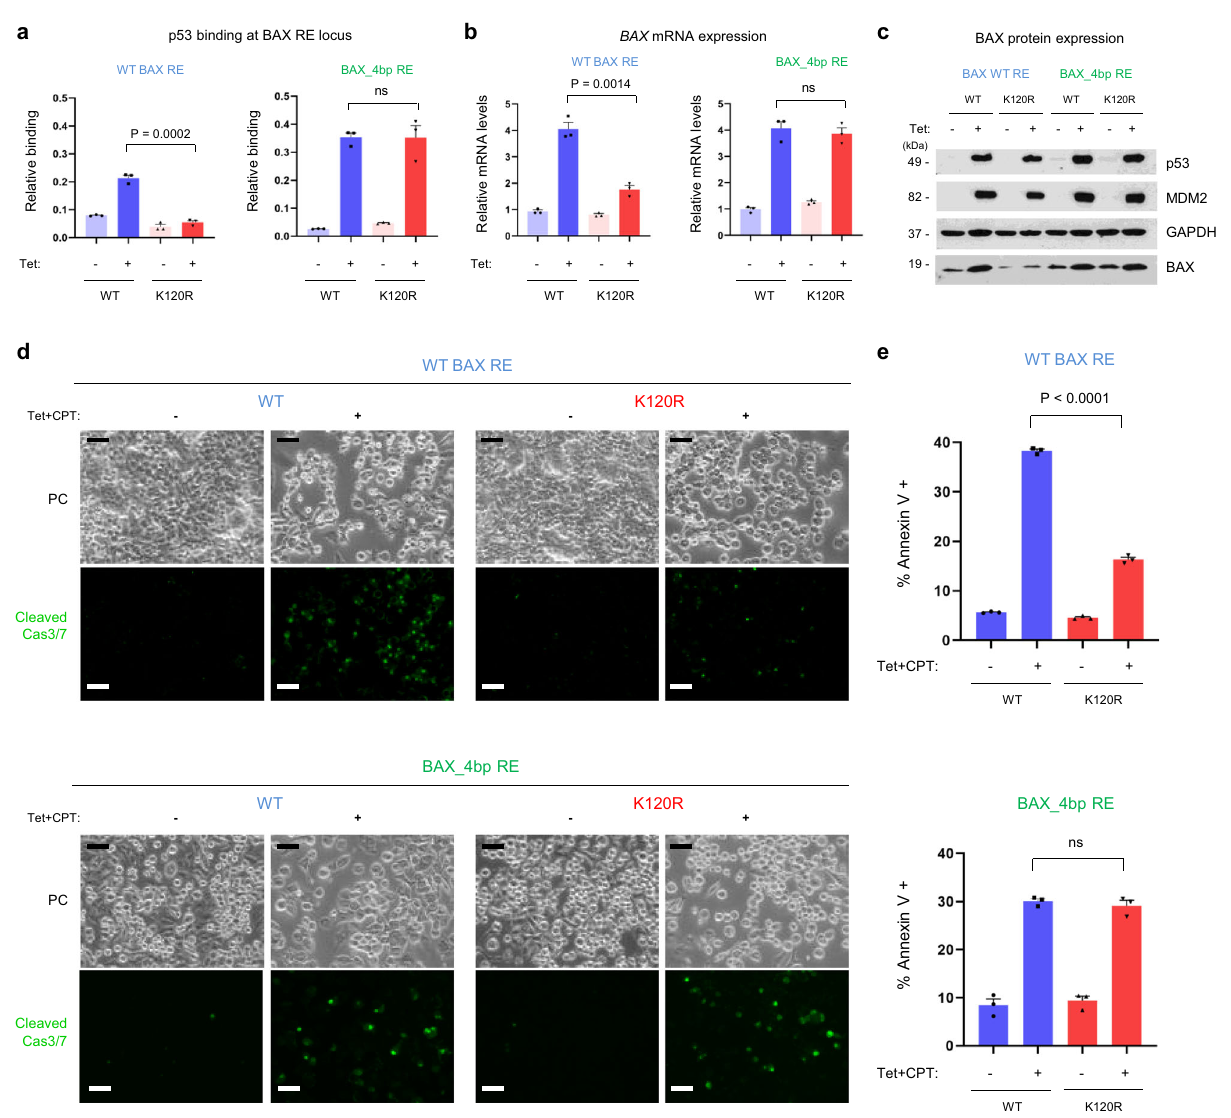
Fig. 5 Genomic editing of BAX RE modi fi es p53 binding and interconverts cell fate outcome. a ChIP signals at the genomic BAX RE locus for WT (blue) and K120R (red) p53 in cells with a WT BAX RE (left) or genetically edited BAX_4bp RE (right). Graphs represent precipitated DNA relative to an input (total) DNA and show cumulative data from three independent experiments (mean ± s.e.m.). b Quantitative polymerase chain reaction (qPCR) of BAX mRNA (represented relative to GAPDH mRNA) from the same cells as in panel a . The graphs show cumulative data from three independent experiments (mean ± s.e.m.). c Representative Western blot from three independent experiments. Blots were probed with antibodies speci fi c for p53, MDM2, GAPDH, and BAX proteins. d Same cells as in panels a – c were treated additionally for 12 h with camptothecin (CPT, 1 μ M; to induce DNA damage) and induction of apoptosis was detected by visualizing cleaved Caspase-3/7 by fl uorescence microscopy ( d ), or by measuring Annexin V positivity by fl ow cytometry ( e ). In both assays, a restoration of pro-apoptotic functions of the K120R-p53 variant in cells with edited BAX RE could be observed. Scale bars, 50 μ m. PC, phase contrast. Representative images from three independent experiments are shown in panel d . Graphs in panel e represent an average percentage of Annexin V-positive cells from three independent experiments (mean ± s.e.m.). Two-tailed unpaired Students t -test was used for statistical analysis in panels a , b , and e . Source data are provided as a Source Data fi